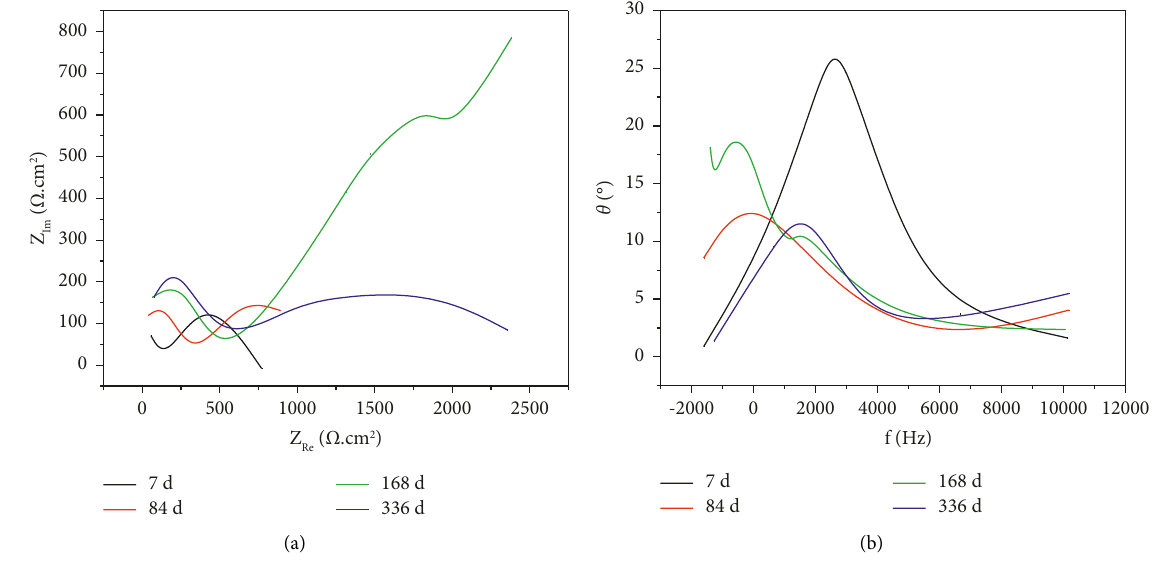
Figure 4: Nyquist diagram and Bode diagram of specimen L2.